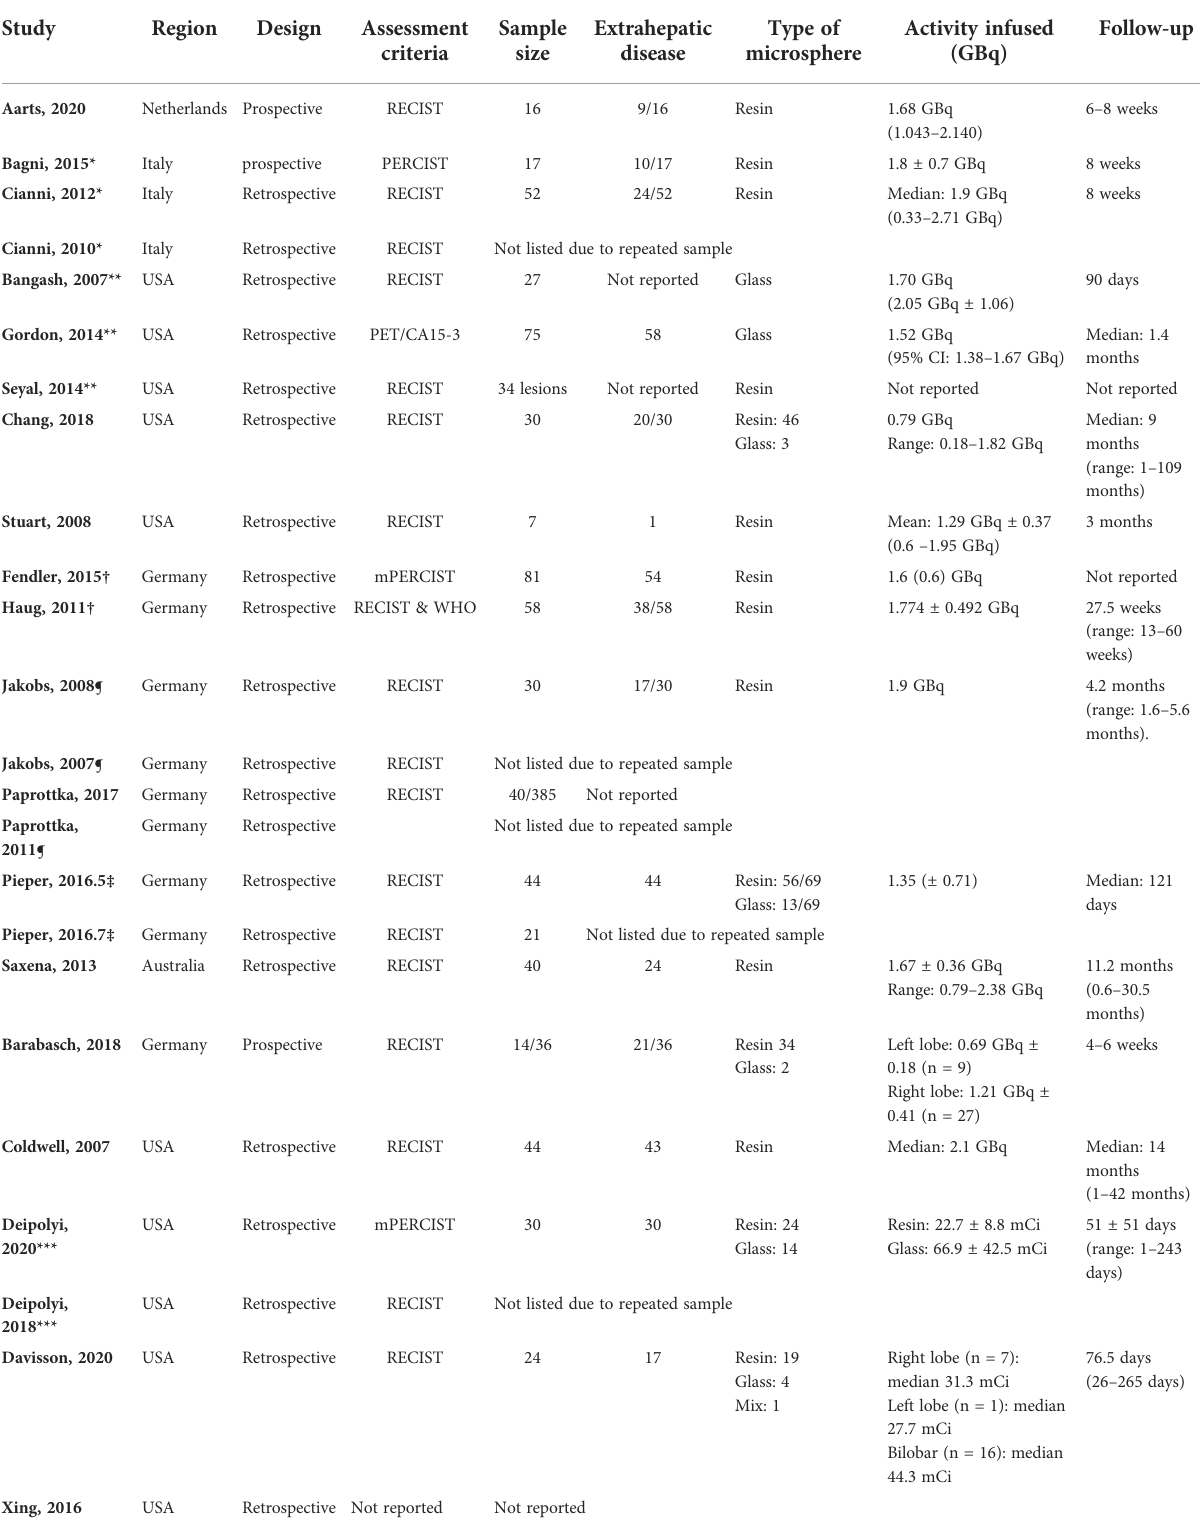
TABLE 1 Baseline characteristics of